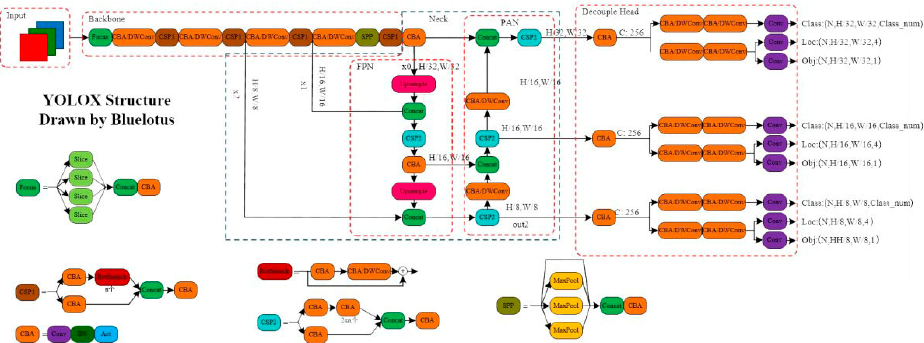
Figure 4. Structural framework of the YOLOX algorithm.